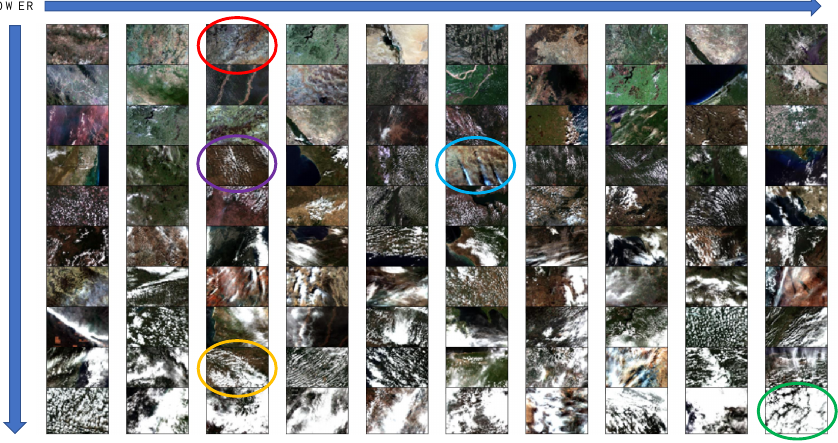
Figure 4. Rank of test images according to cloud coverage from labels. Colored circles are used to tag